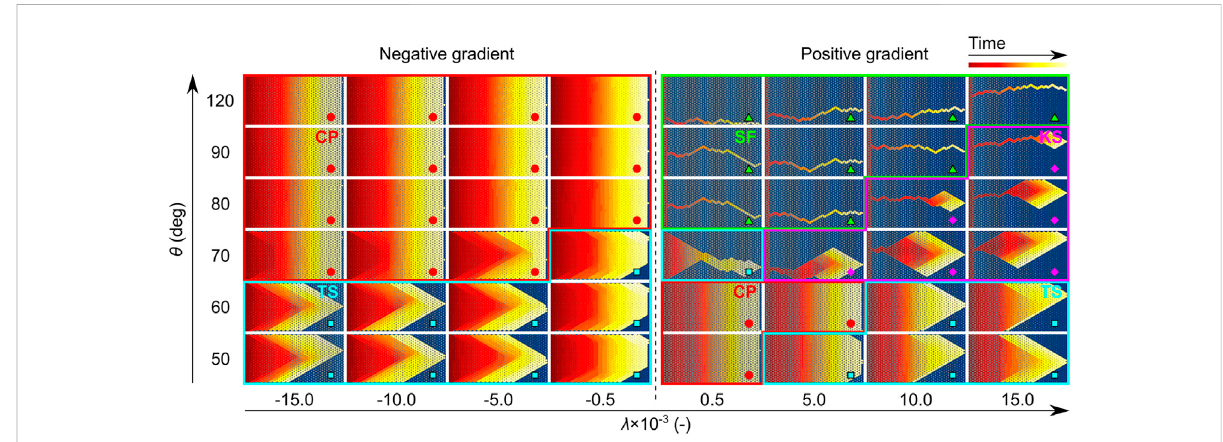
FIGURE 9 Simulateddisplacementpatternswith λ increasesfromlefttorightandwith θ increasesfromthebottomtotop.The fl owdirectionisfromleftto right. Red and yellow represents the invading phase, while blue represents the defending phase. The dark red to the light red to the yellow indicates the invasion process of the initial stage and the late time. Red circles, blue squares, purple diamonds, and green triangles represent displacement patterns of the compact pattern (CP), taper shape pattern (TS), kite shape pattern (KS), and single fi ngering pattern (SF), respectively. The displacement patterns for the 168 simulated cases are shown in Supplementary Figures S4,